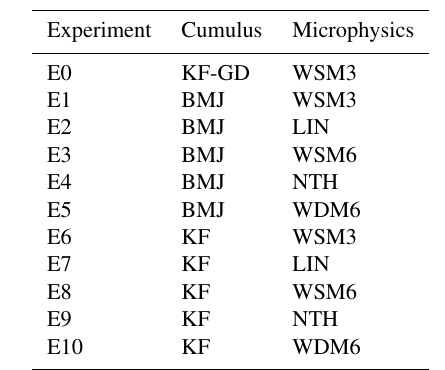
Table 1. Configurations of parameterizations for tested experi-